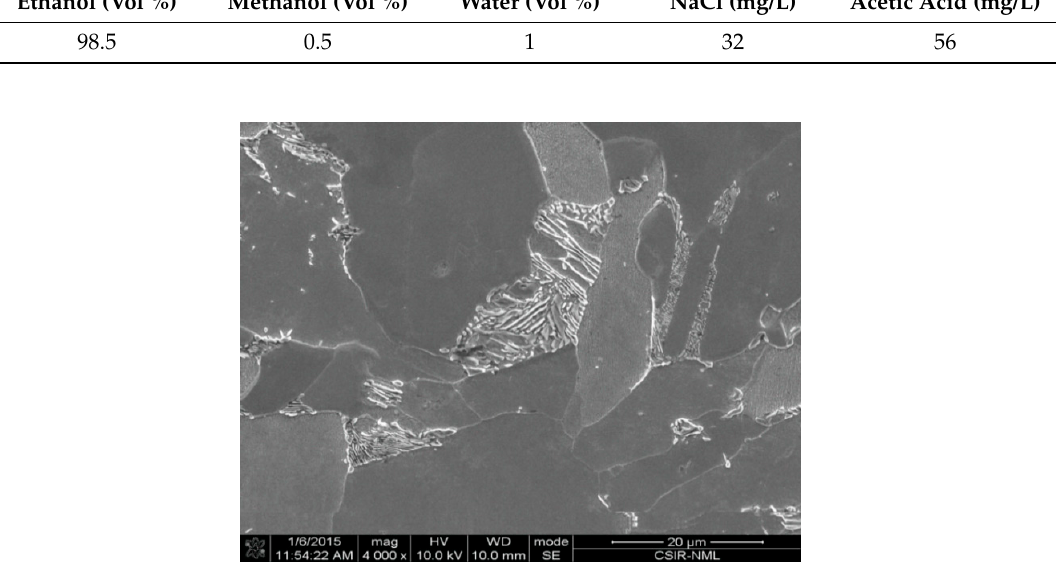
Table 2. Baseline composition of simulated fuel ethanol based on ASTM D4806 [14].